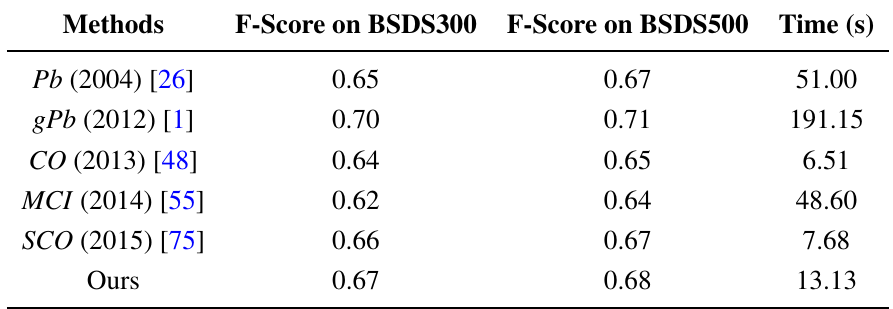
Quantitative comparison of various models on the BSDS300 [26] and BSDS500 [1] images with the